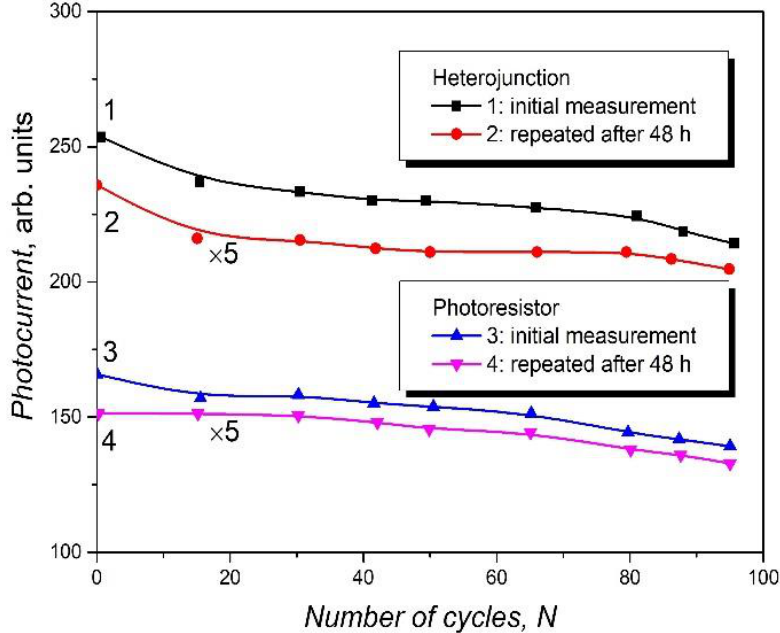
Figure 6. Dependence of the photocurrent as a function of the number of bending cycles ( N ) at 15 ◦ for p –InSe:Cd/In 2 O 3 heterojunctions (1, 2) and photoresistor based on the single-crystalline p –InSe:Cd plate (3, 4); curves 1 and 3 are the initial measurements; curves 2 and 4 are measurements repeated after 48 h.